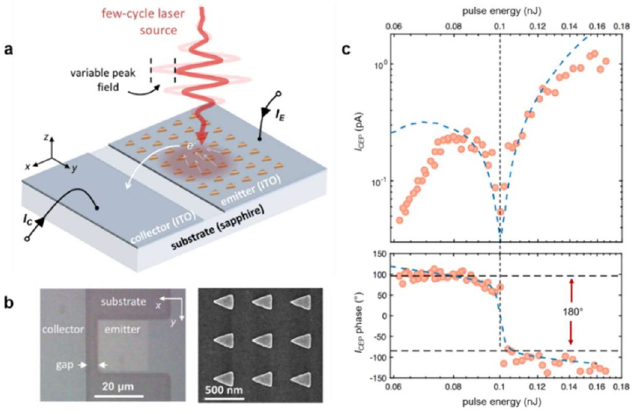
Fig. 1: a. Experimental setup. Few-cycle laser pulses of tunable pulse energy and peak field produce photoemission currents from gold nanotriangles, and these currents are pulled from an emitter electrode to a collector (emitter and collector currents are labeled 𝐼 (cid:3006) and 𝐼 (cid:3004) respectively). b. Optical and electron microscope images of a nanotriangle emitter array. c. Measured CEP-sensitive current ( 𝐼 CEP ) versus the incident pulse energy. In the bottom panel, the relative phase of 𝐼 CEP and the 𝑓 CEO reference is displayed. Simulated 𝐼 CEP values (blue, dashed line) calculated using a quasi-static tunneling model show remarkable agreement to the experimental data. We stabilized the CEP of our few-cycle laser source by locking the carrier-envelope offset frequency, 𝑓 CEO , to a stable 100 Hz reference. We measured the CEP-sensitive component of the emission current, i.e. the component of the current at 𝑓 CEO , via lock-in detection in a 125 mHz bandwidth. In the top panel of Fig. 1c, the CEP-sensitive current, denoted 𝐼 CEP , is displayed versus driving pulse energy; in the bottom panel the phase of 𝐼 CEP relative to the 𝑓 CEO reference is also plotted. We see that 𝐼 CEP displays antiresonant-like behavior: near 100 pJ pulse energies the magnitude of 𝐼 CEP abruptly dips, and the phase of 𝐼 CEP swings by ≈ 180 ∘ . To understand the origins of this behavior, we used a quasi-static tunneling